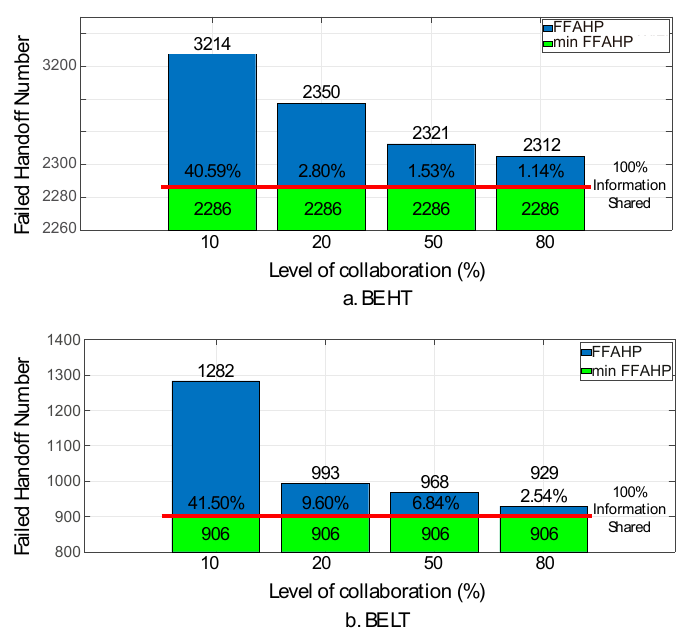
Figure 19. Relation of failed handoffs for FFAHP: ( a ) Real time (RT) and high traffic (HT); ( b ) Real time (RT) and low traffic (LT).